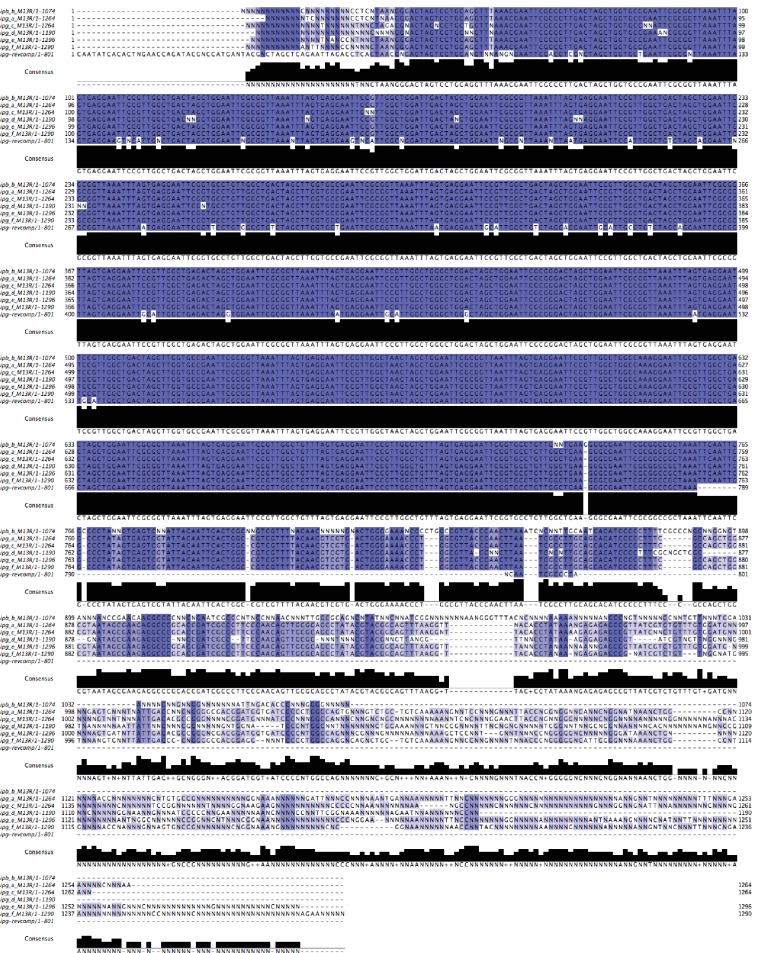
Alignment of the original cenRNA1 with new sequencing results.Adjustment was performed when similar uncalled bases (12 N’s) or called bases (27) were found in the six clones (~6% of total sequence changed).